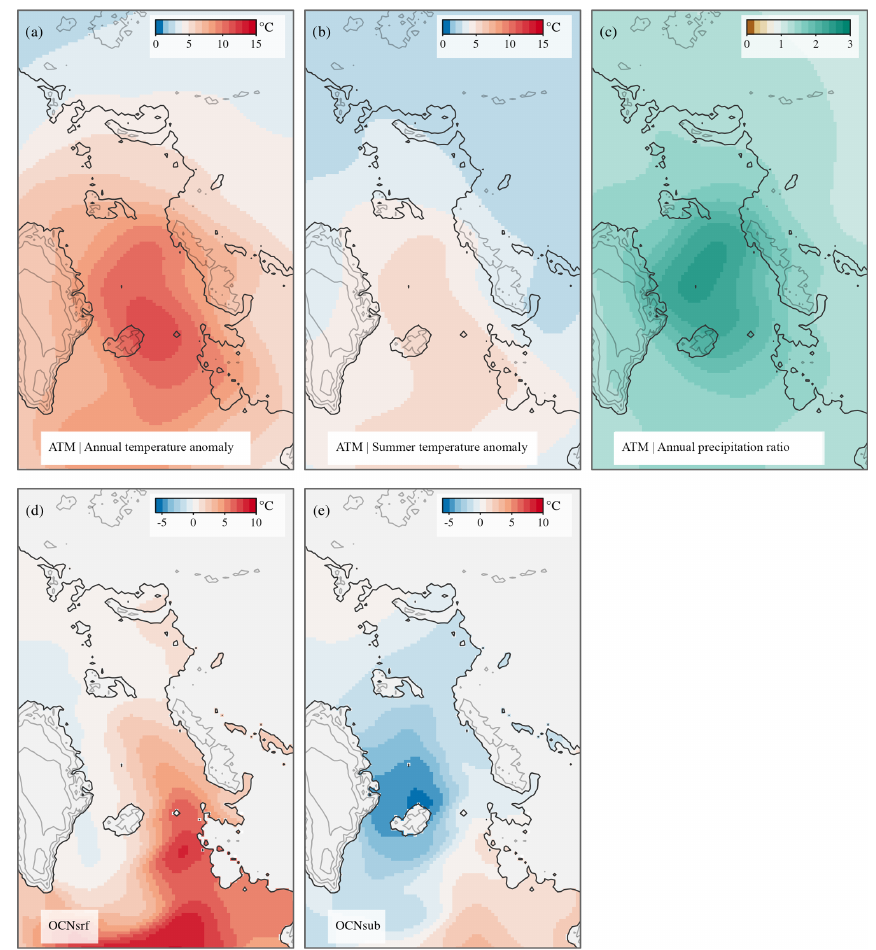
Figure 3. Millennial-scale components of the boundary forcing. (a) SAT anomalies (interstadial minus stadial) in degrees Celsius. (b) Sum- mer SAT anomalies (interstadial minus stadial) in degrees Celsius. (c) Precipitation ratio (interstadial to stadial). (d) Anomalies of SST and (e) subsurface ocean temperature (at a depth of 500m) in degrees Celsius. Present-day contour lines with the land boundary delineated at a depth of − 80m are added for reference. Note that to force the ice-sheet model these fields are scaled to reproduce the NGRIP interstadial minus stadial temperature